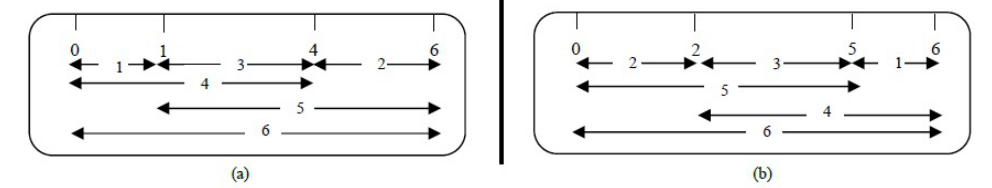
Figure 1: (a) A 4–marks optimal and perfect Golomb ruler with its associated distances and; (b) it’s mirror